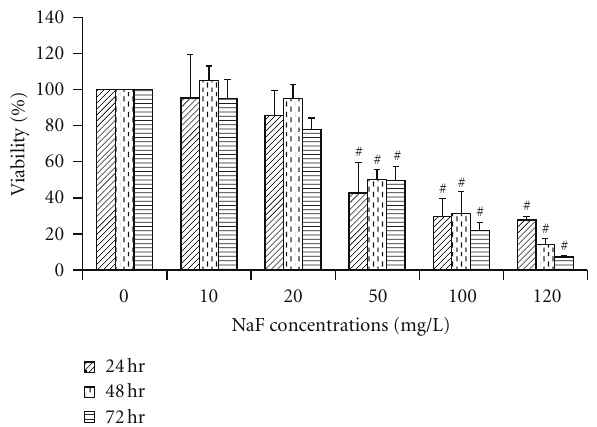
Figure 1: E ff ects of fluoride on cell viability in microglial BV-2 cells. Cells were treated with various concentrations of NaF and incubated for 24, 48, and 72h. Cell viabilities were measured using MTT assay, and data were presented as a percentage of the control. # P < 0 . 01 compared to the control